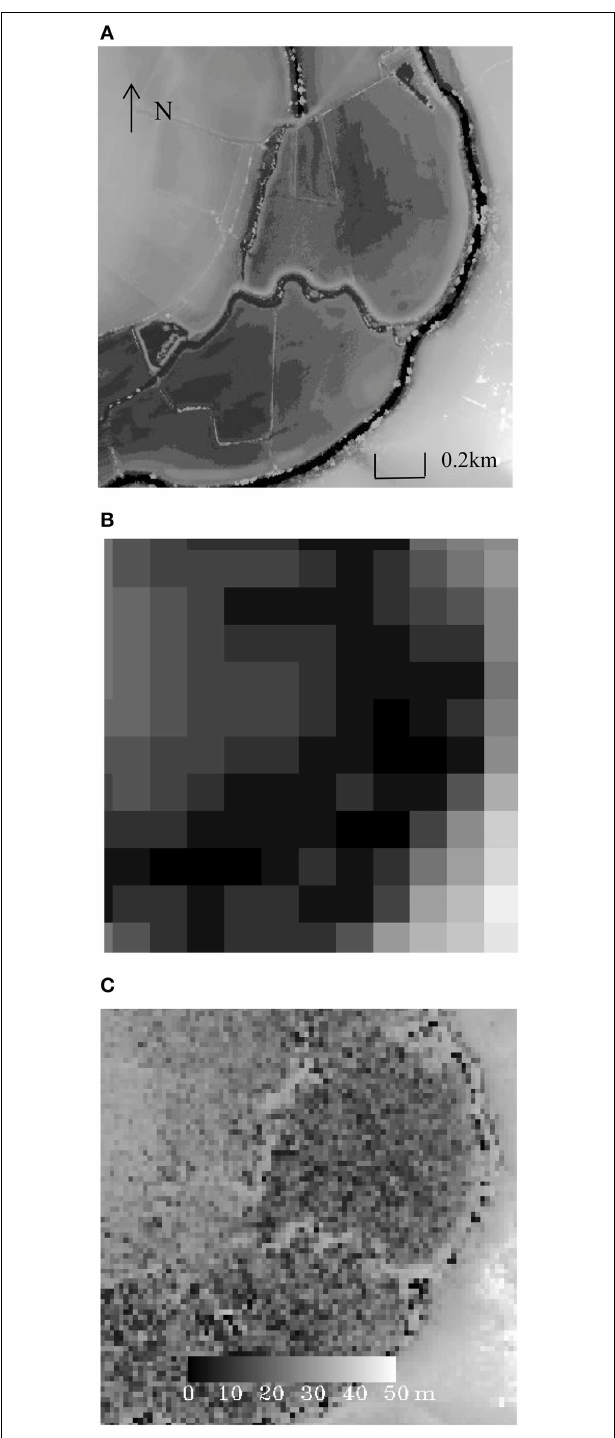
FIGURE 8 | (A) LiDAR DEM of a sub-area of Figure 9 (2.5m pixels, 1 × 1 km), (B) SRTM DEM (90m pixels), (C) TanDEM-X IDEM (12.5m pixels, © DLR 2007) (after Mason et al.,